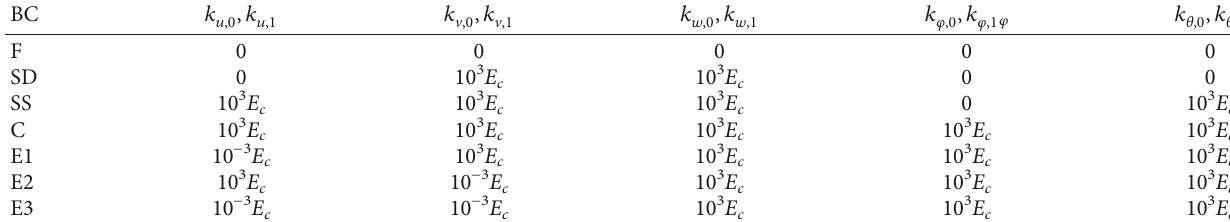
Table 1: The spring stiffness values of the general boundary